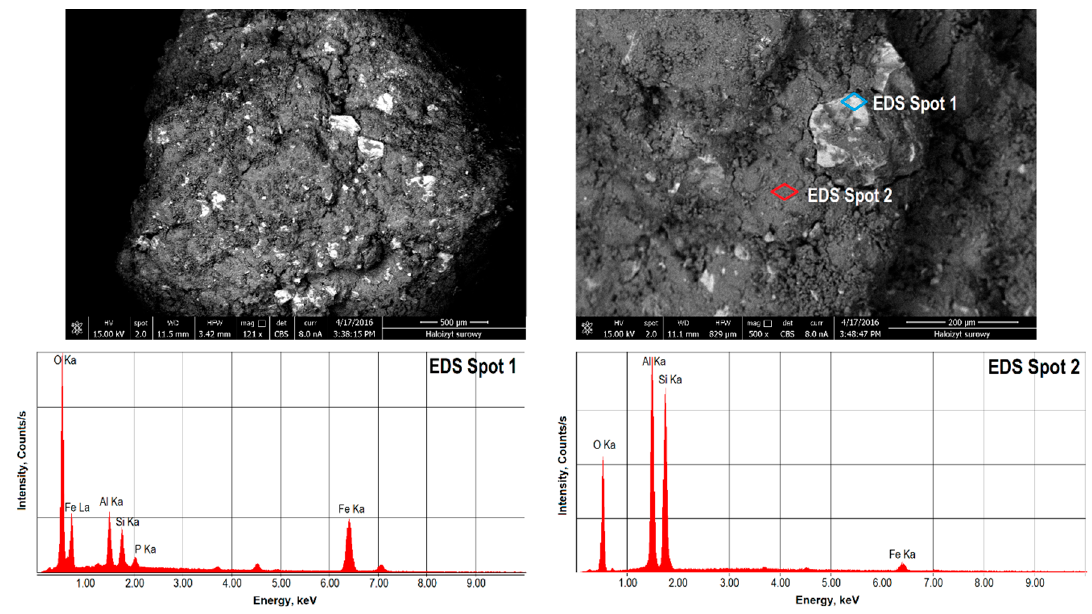
Figure 2. SEM image of the microstructure of the surface of raw halloysite R-HAL and chemical composition determined by an X-ray dispersion energy spectrometer (EDS).